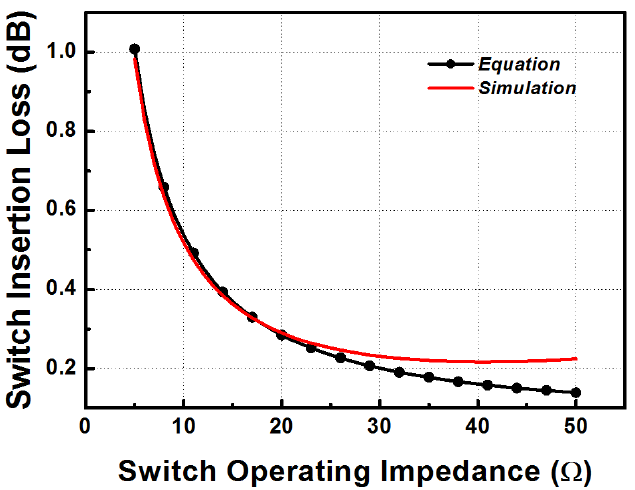
Figure 9. Insertion loss of a single switch device versus switch operating impedances.